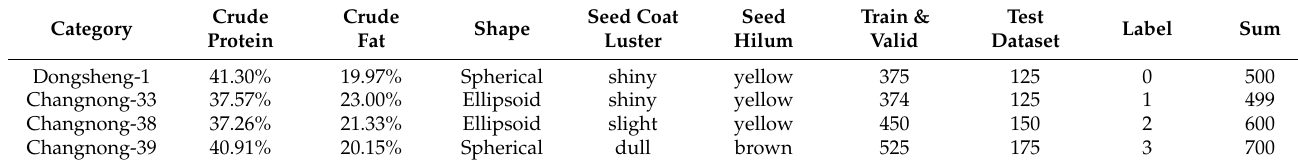
Table 1. Basic soybean information of nutrition and experiment dataset construction.